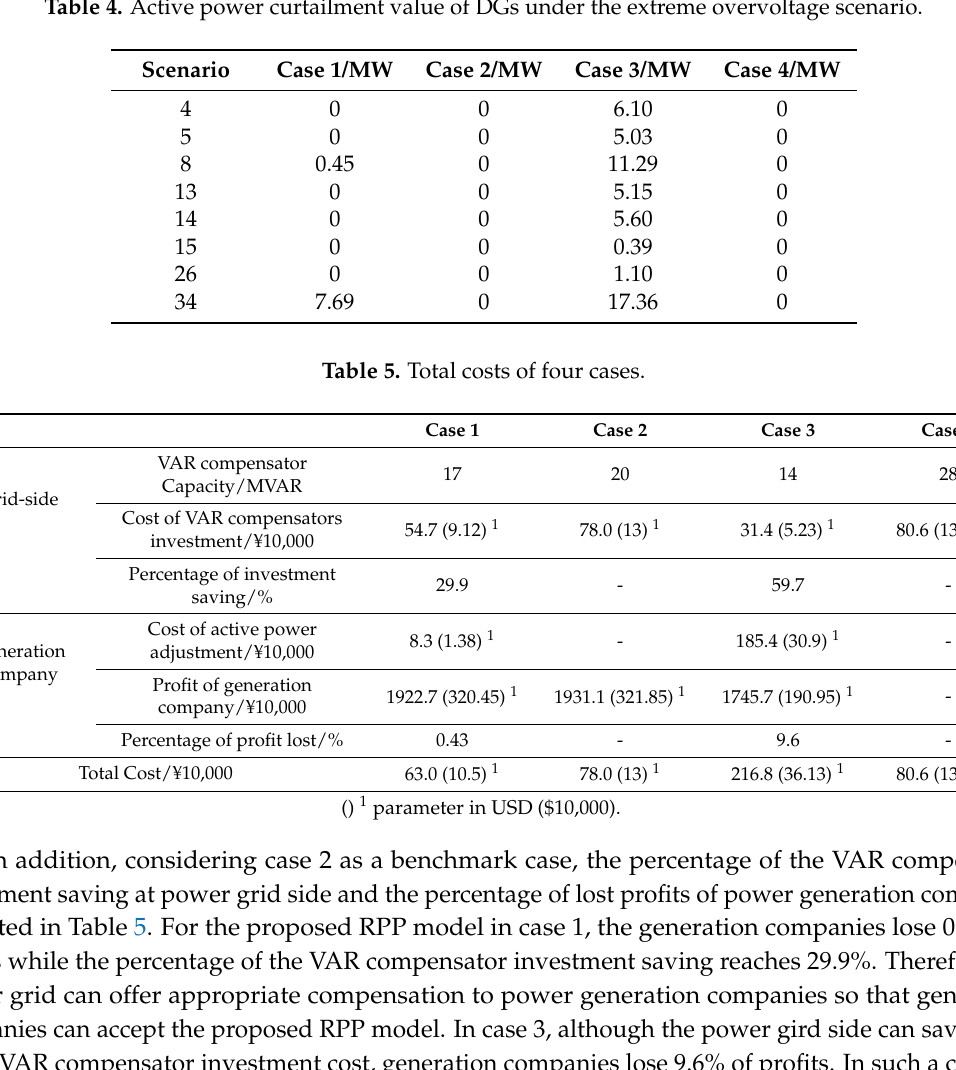
Table 4. Active power curtailment value of DGs under the extreme overvoltage scenario.